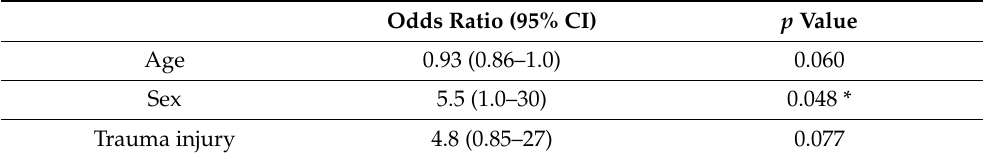
Table 5. Results of the multivariate logistic